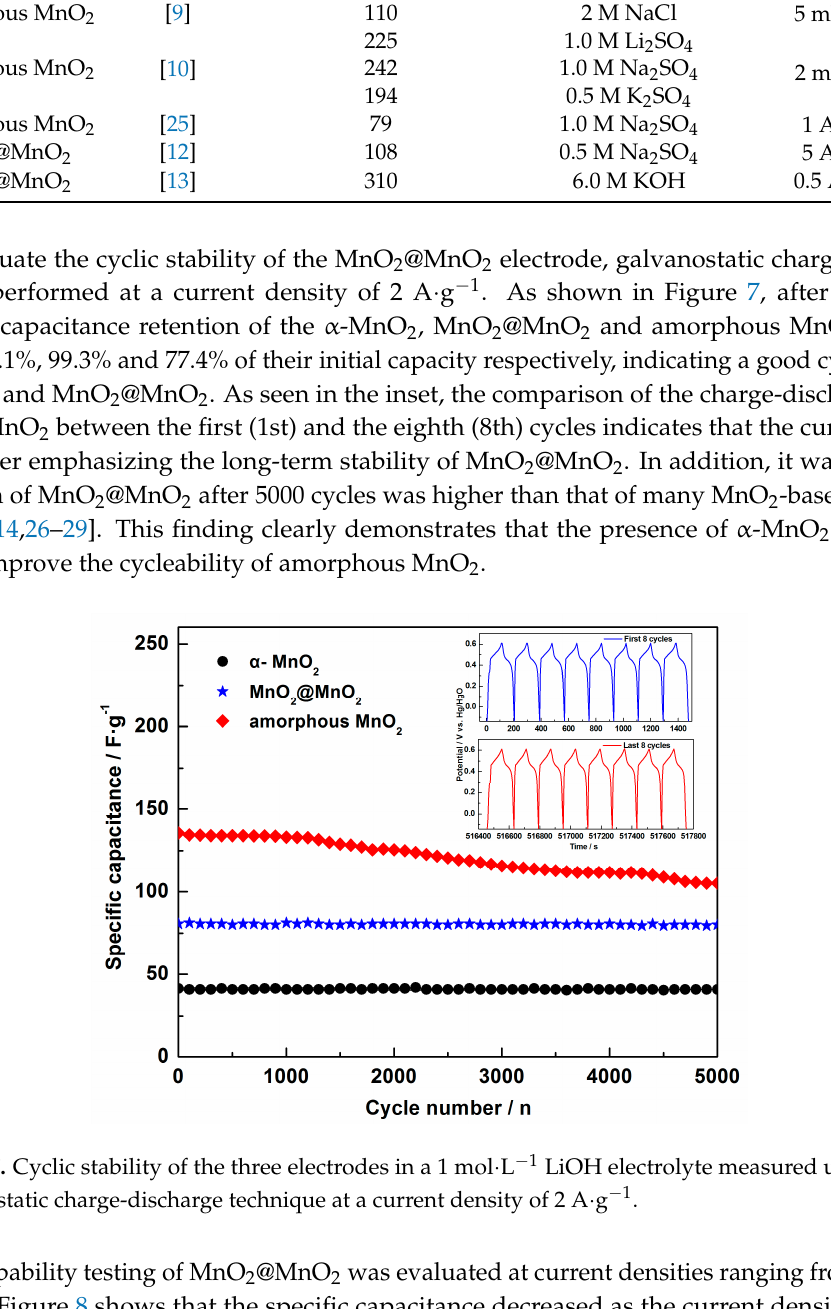
Table 1. Comparison of the specific capacitance of as-prepared electrodes to other reported amorphous MnO 2 and MnO 2 @MnO 2 electrodes.